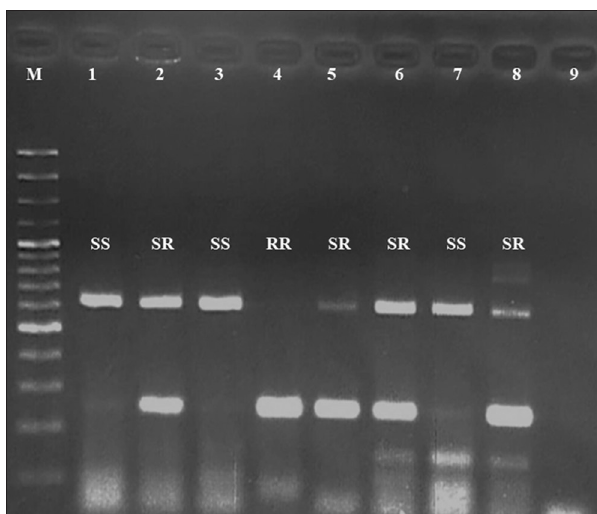
Figure-2: Polymerase chain reaction product of β-tubulin gene from Haemonchus contortus , lane M is DNA ladder (100 bp), lane 1-8 is PCR product of β-tubulin gene, lane 9 is negative control. The genotype; homozygous resistant (RR), homozygous susceptible (SS), and heterozygous